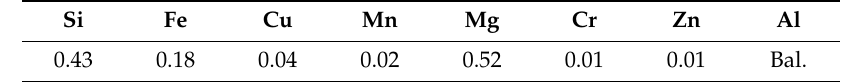
Table 2. Chemical composition of the aluminum alloy (A6063) tube used in this study (mass percentage).